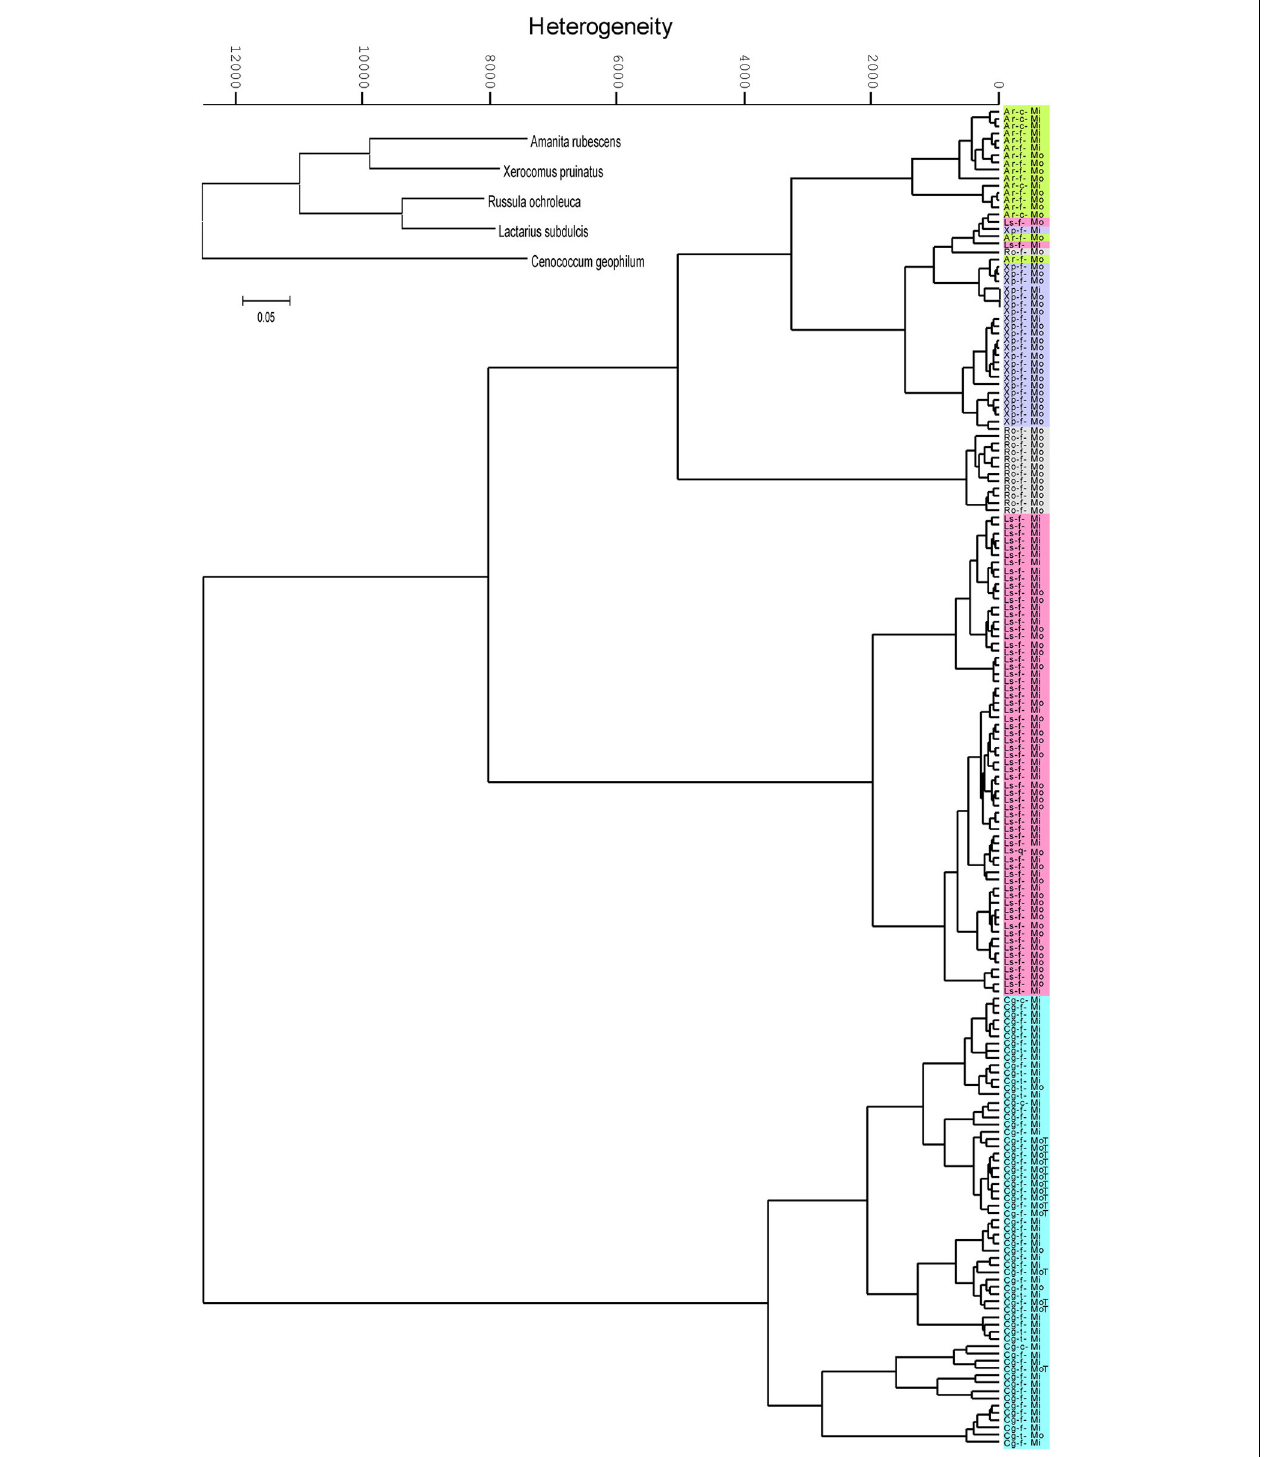
FIGURE 2 | Dendrogram of the second derivative of ectomycorrhizal FTIR spectra, clustered by Ward’s algorithm in the range between the wavenumbers from 3000 to 2800 and from 1700 to 600cm − 1 . Ectomycorrhizasofbeech(f),lime(t)andhornbeam(c)with Amanitarubescens